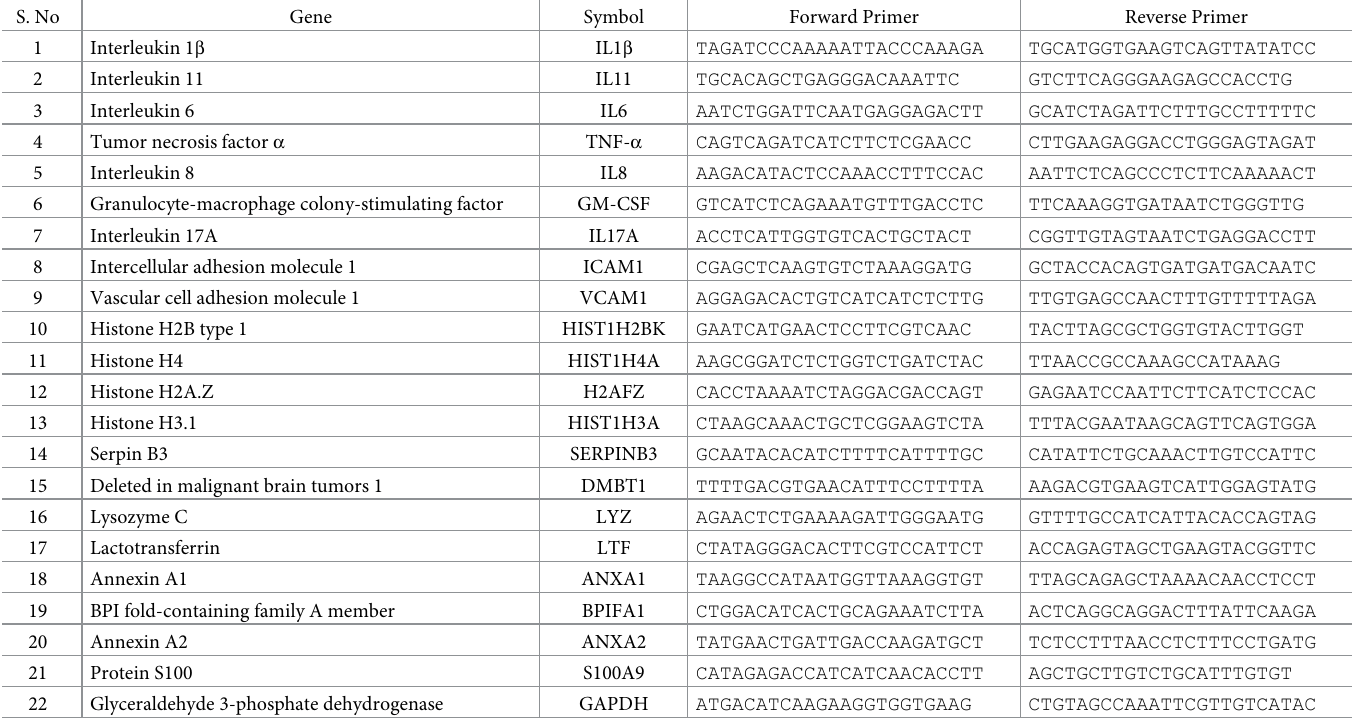
Table 3. List of genes and their primer pairs used for the RTPCR validation.